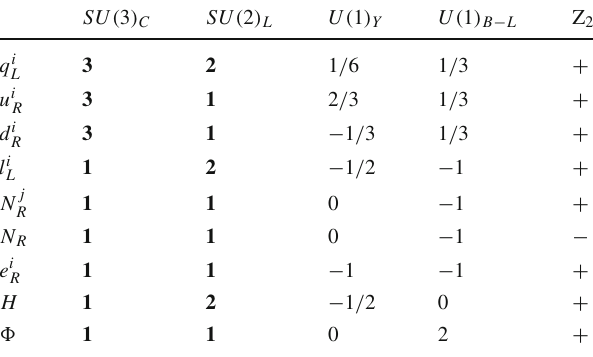
Table1 Theparticlecontentoftheminimal B − L modelwiththeRHN DM [36]. In addition to the SM particle content ( i = 1 , 2 , 3 for three generations), the three right-handed neutrinos categorized into 2+1 ( N j ( j = 1 , 2) and N R ) and the B − L Higgs field ( (cid:12) ) are introduced. The Z 2 -odd N R is a unique DM candidate in the